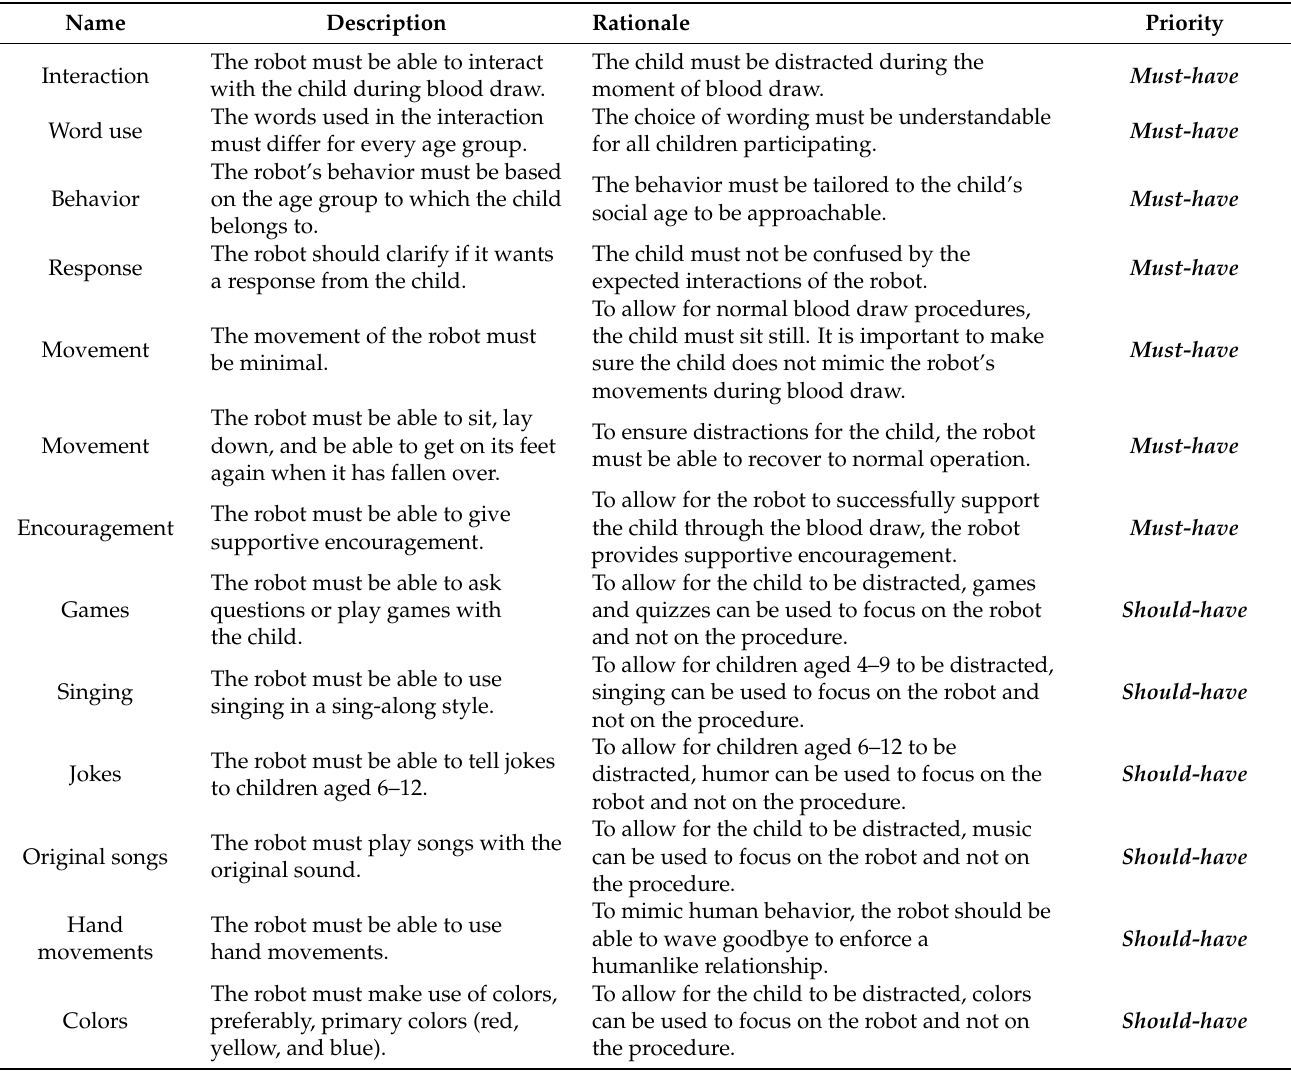
Table 2. Design requirements for a social robot to mitigate pain and anxiety during blood collection in children.